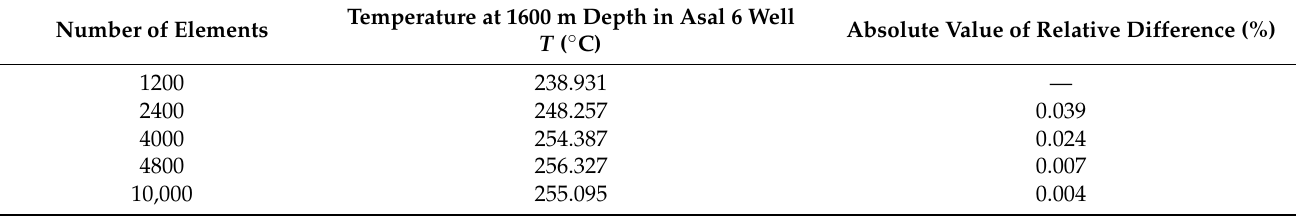
Table A1. Verification of mesh independence for simulation of scenario